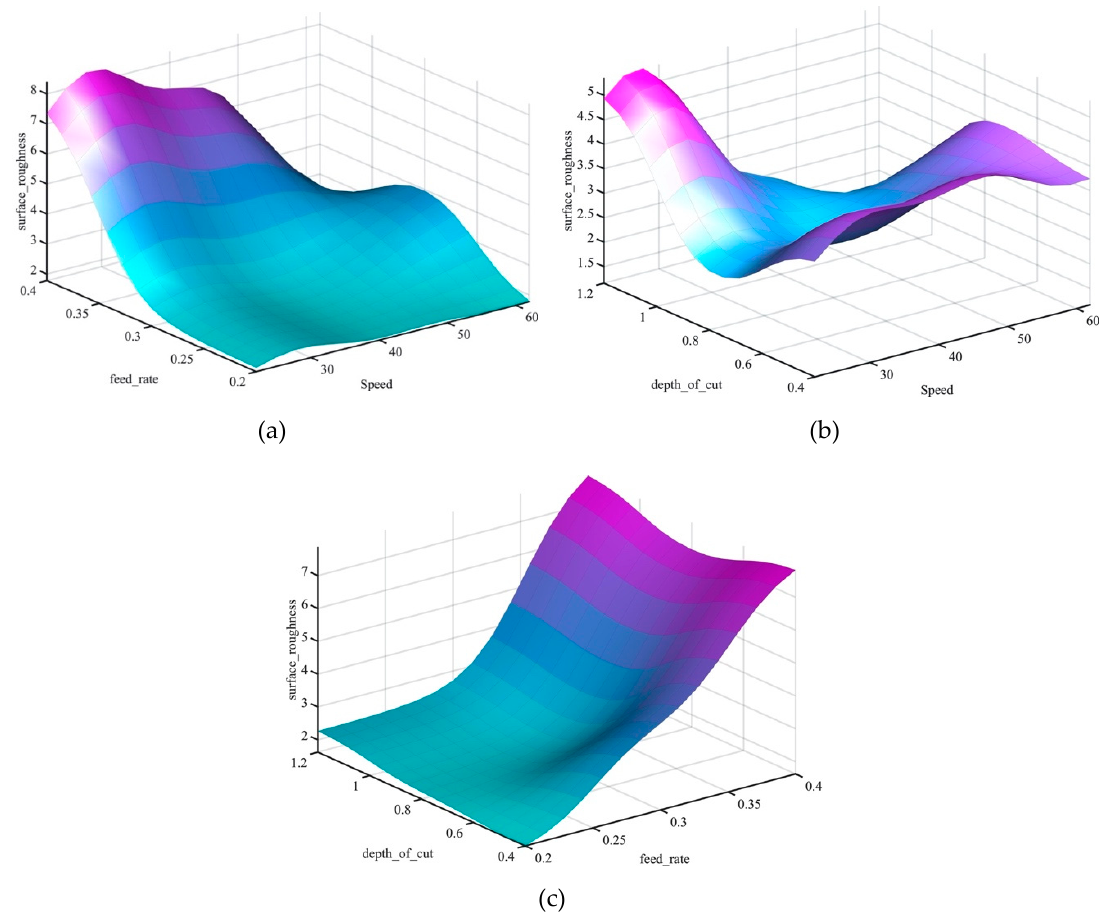
Figure 9. Surface plots of machining parameters vs. surface roughness of a dry turning process, ( a ) feed rate vs speed influence on surface roughness, ( b ) depth of cut vs speed influence on surface roughness, ( c ) depth of cut vs feed rate influence on surface roughness.